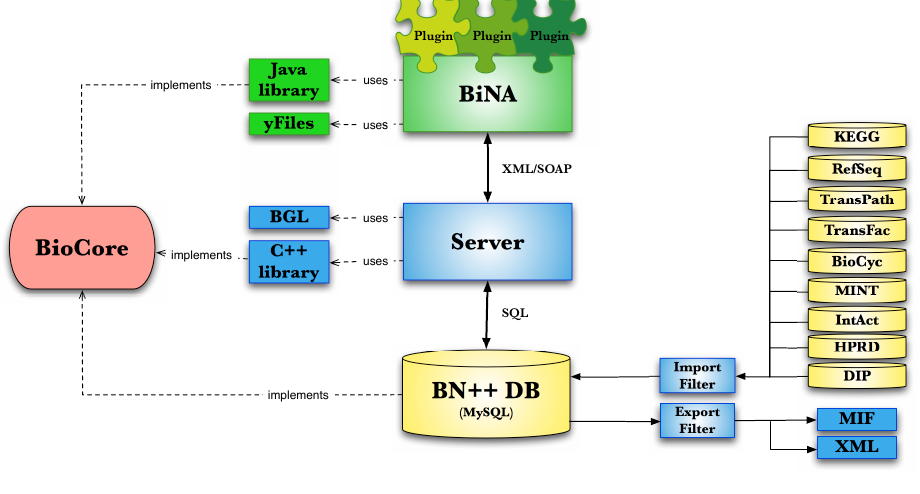
Figure 1: Architecture of BN++